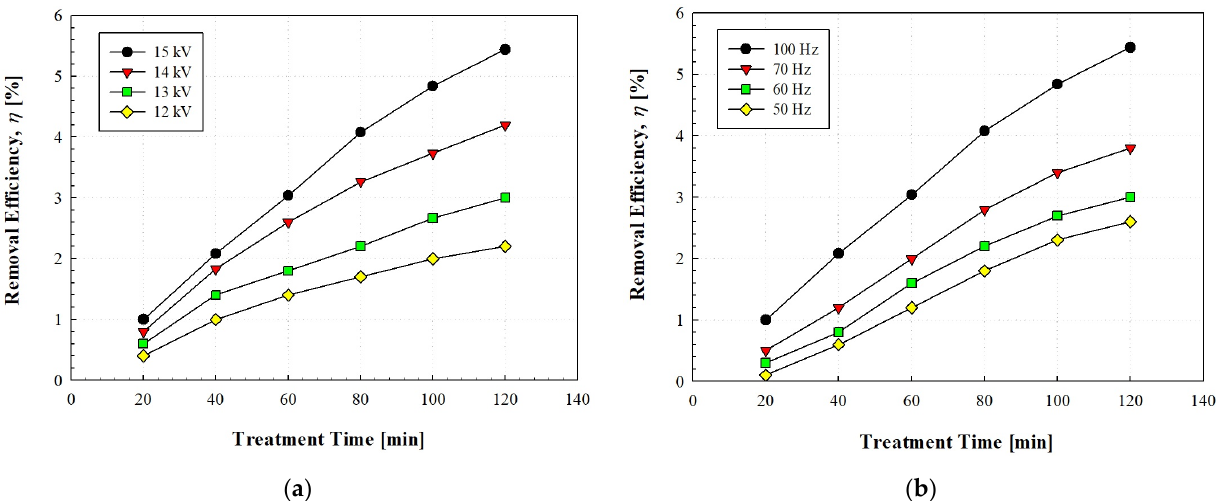
Figure 4. ( a ) 𝜂 –treatment time graph by applied voltage ( b ) 𝜂 –treatment time graph by frequency. Figure 4. ( a ) η –treatment time graph by applied voltage ( b ) η –treatment time graph by frequency.